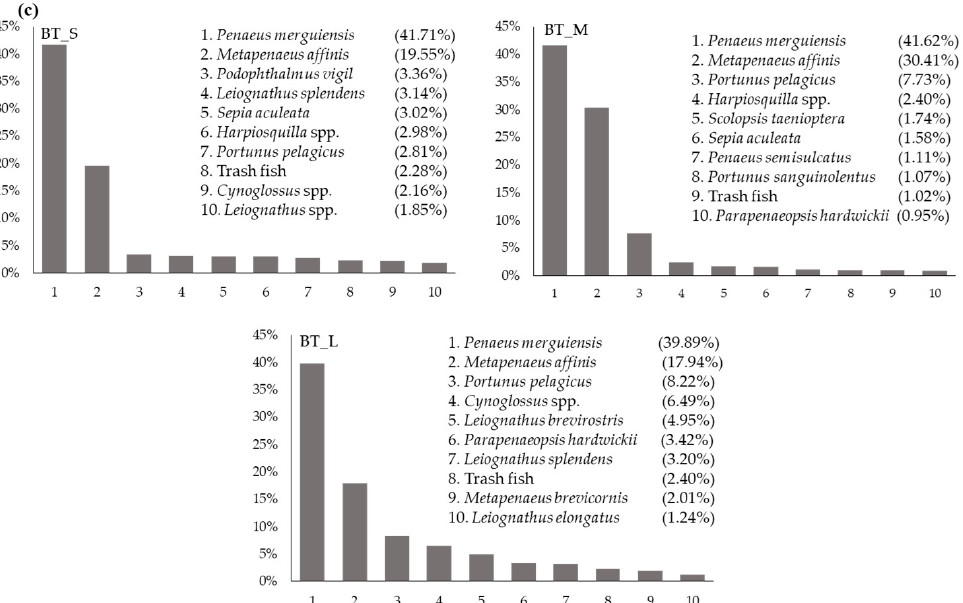
Figure 1. Top ten taxa, by weight, in landings of trawl fisheries in the Gulf of Thailand, by trawl type and vessel size. Trawl type: ( a ) OBT = Otter-board, ( b ) PT = Pair trawl and ( c ) BT = Beam trawl. Vessel size: SS (<10 gross tonnage, GT), S (10–29.9 GT), M (30–59.9 GT), L (60–149.9 GT) and XL (>150 GT).